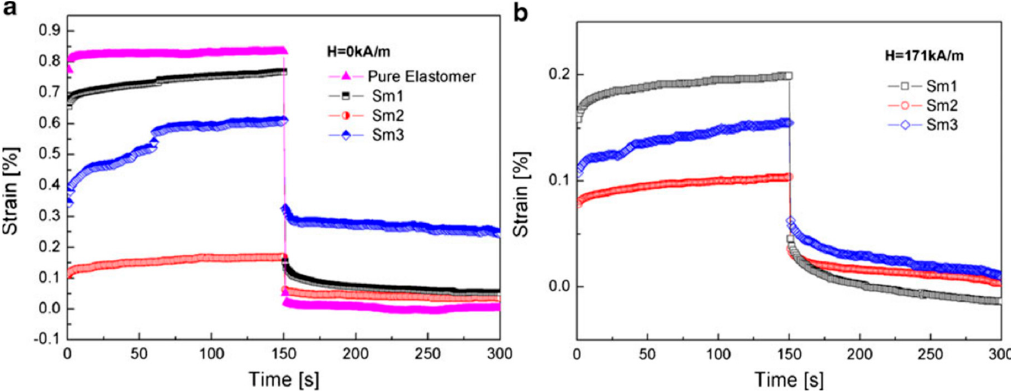
Figure 7. Creep and recovery curves of pure elastomer and the MR elastomer samples without ( a ) and with ( b ) the stimuli of a magnetic field (171 kA/m). Applied stress is 30 Pa (reprinted with permission from [119], Copyright 2012 Springer-Verlag, Berlin, Germany).